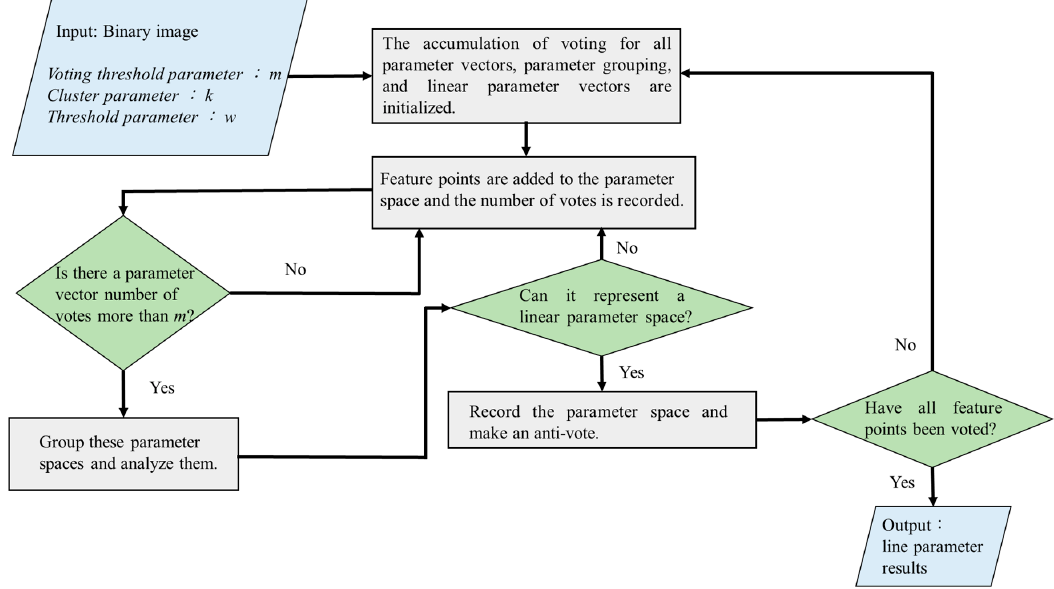
Figure 11. Flow chart of the probabilistic Hough transform (PHT). ( m —each edge point votes for the parameter pairs of all straight lines on which it can lie; k —group the parameter from m ; w —the “winning” lines correspond to the largest collinear subsets of edge points in the image).